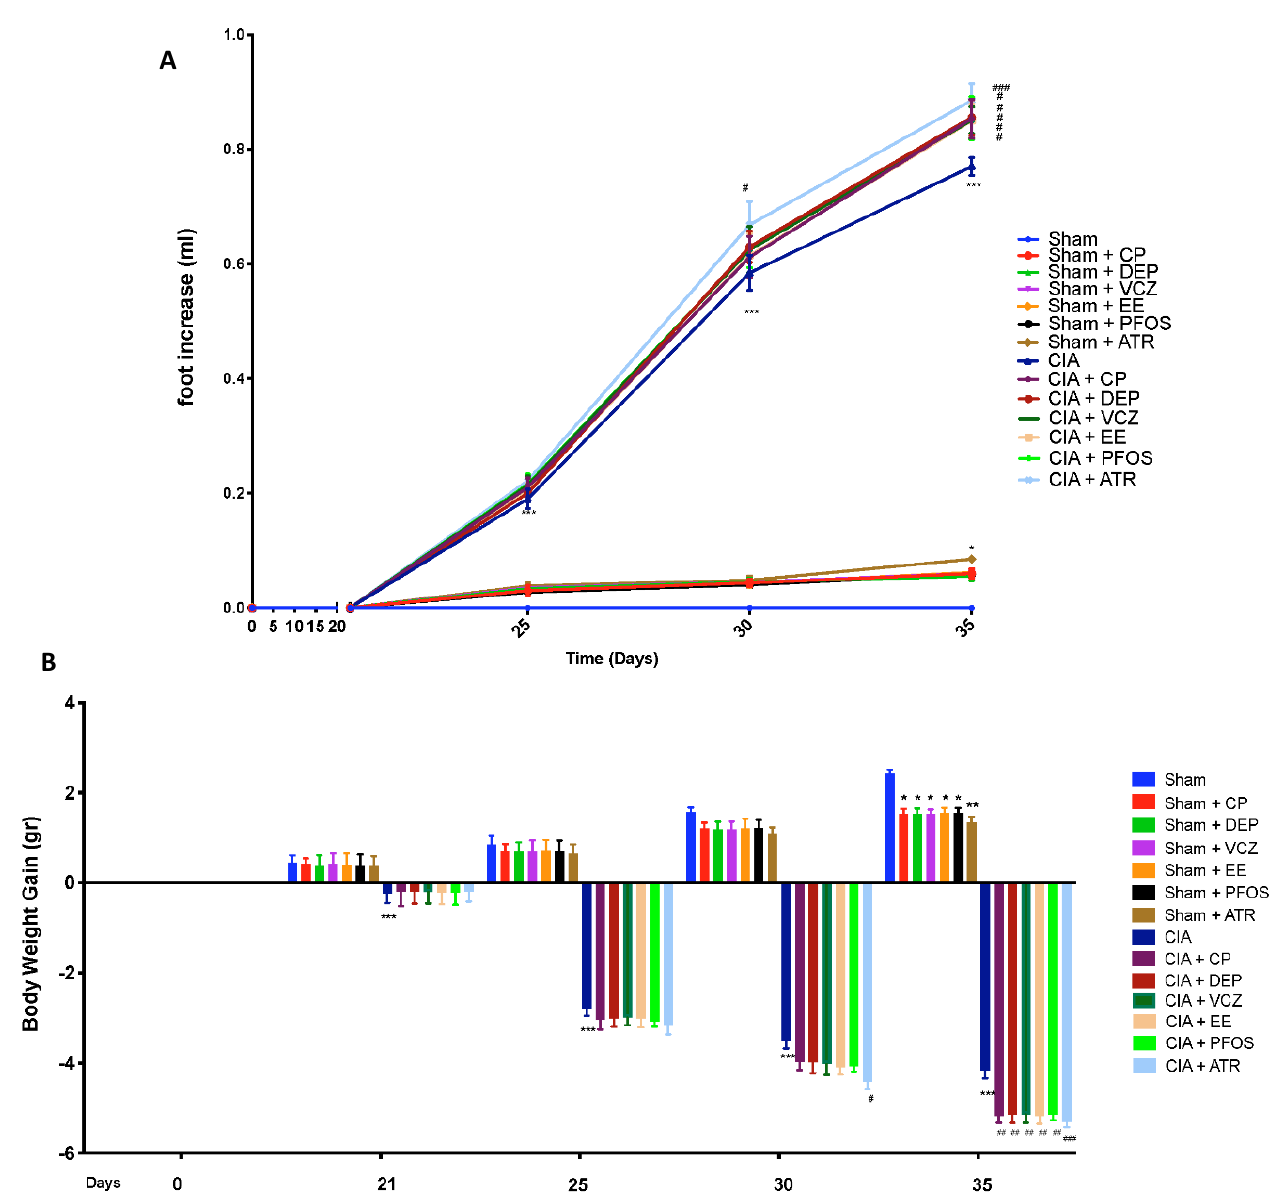
Figure 3. Variation in paw volume ( A ); gain in body weight ( B ). * p <0.05 vs. sham; ** p < 0.01 vs. sham; *** p < 0.001 vs. sham; # p < 0.05 vs. CIA; ## p < 0.01 vs. CIA; ### p < 0.001 vs. CIA.